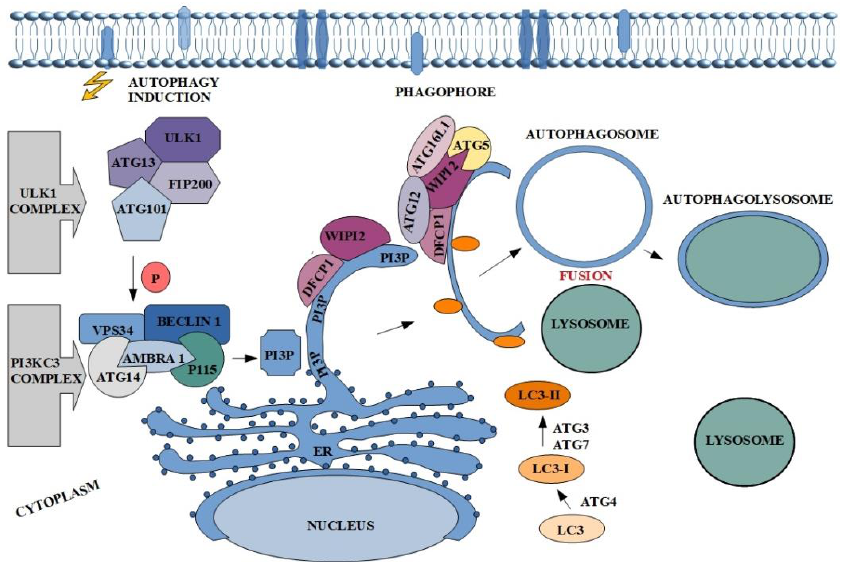
Figure 1. The course of the autophagy along with the main proteins involved in the process. The description of the figure can be found in the text above.